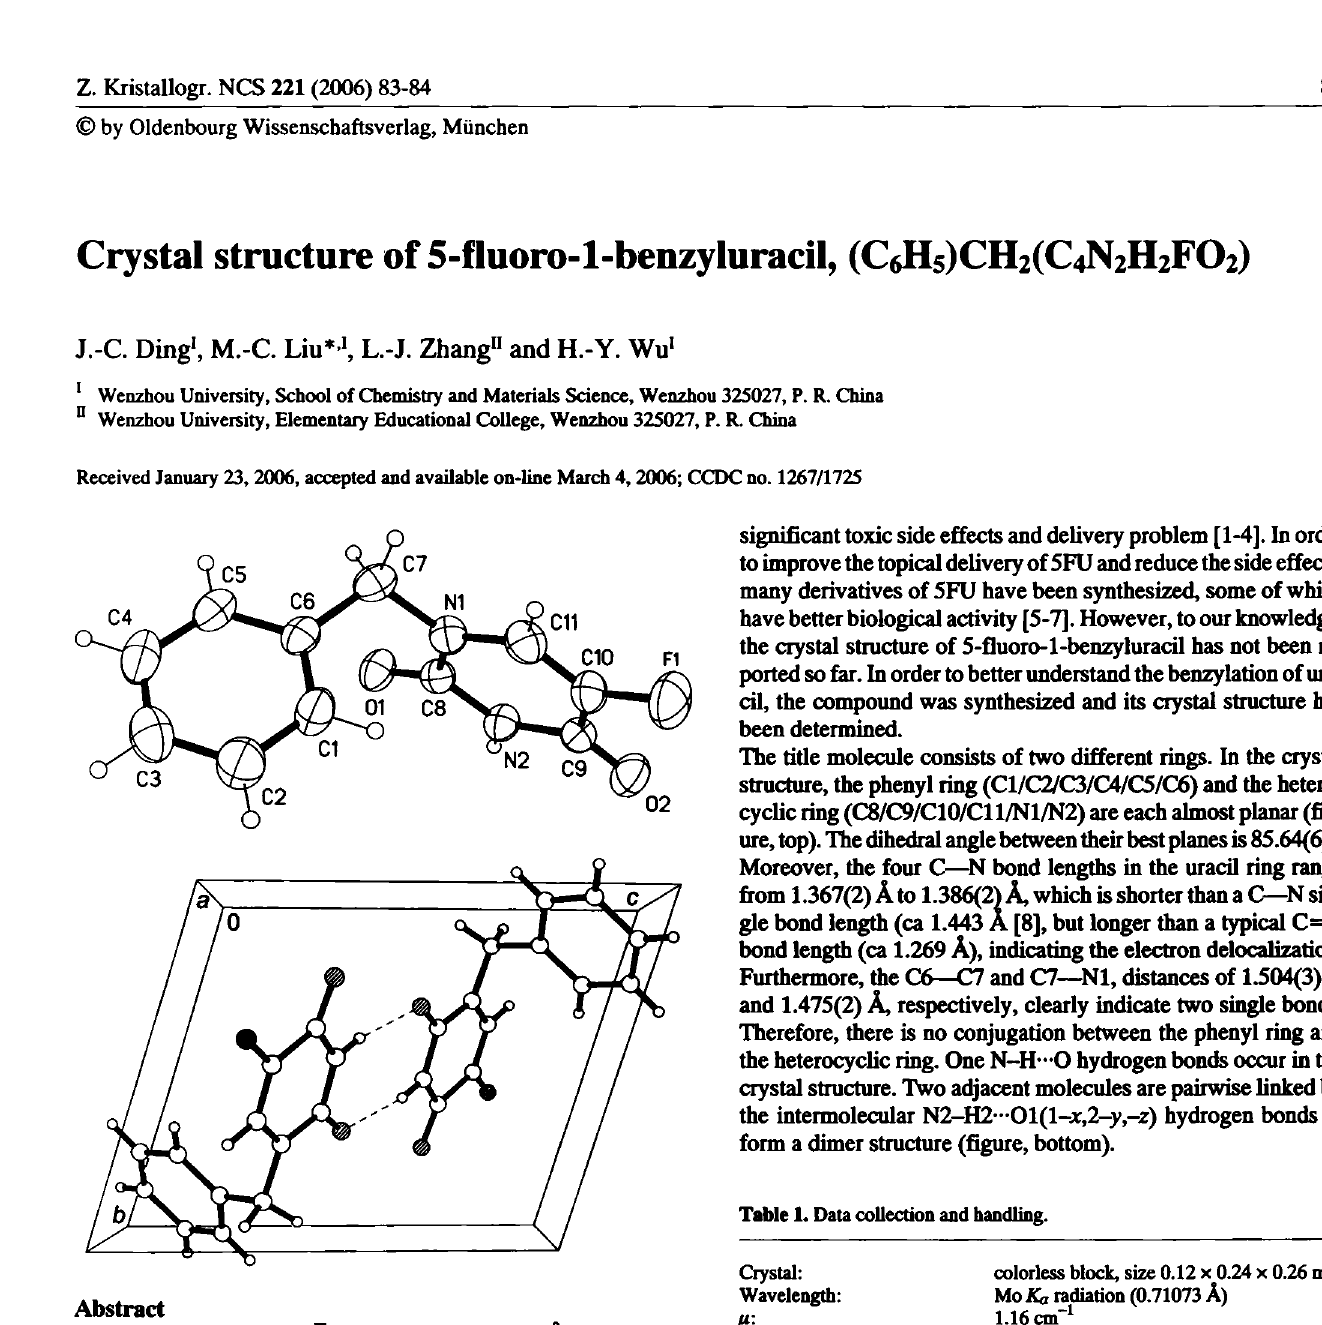
Table 1. Data collection and handling.